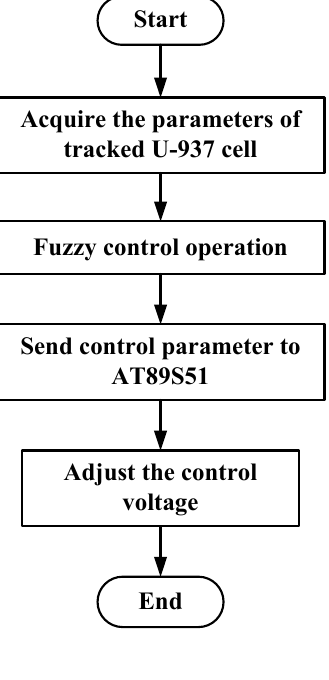
Figure 7. Flow chart of electroosmotic